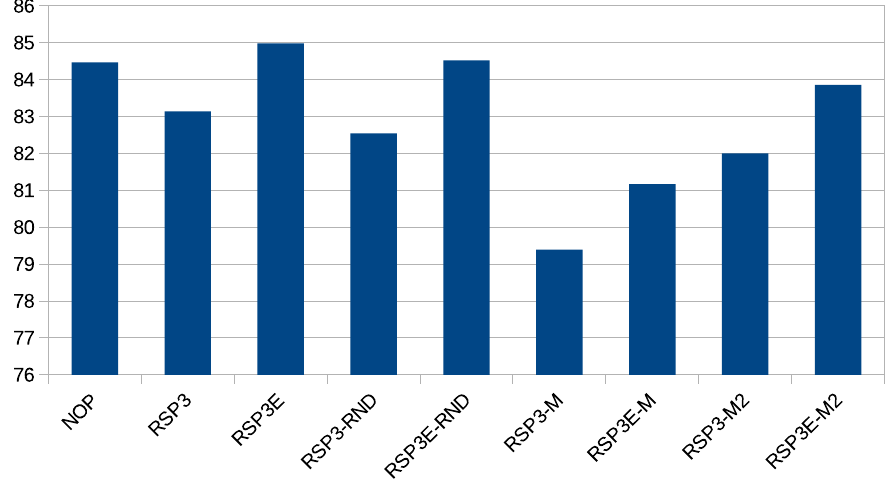
Figure 4. Average accuracy